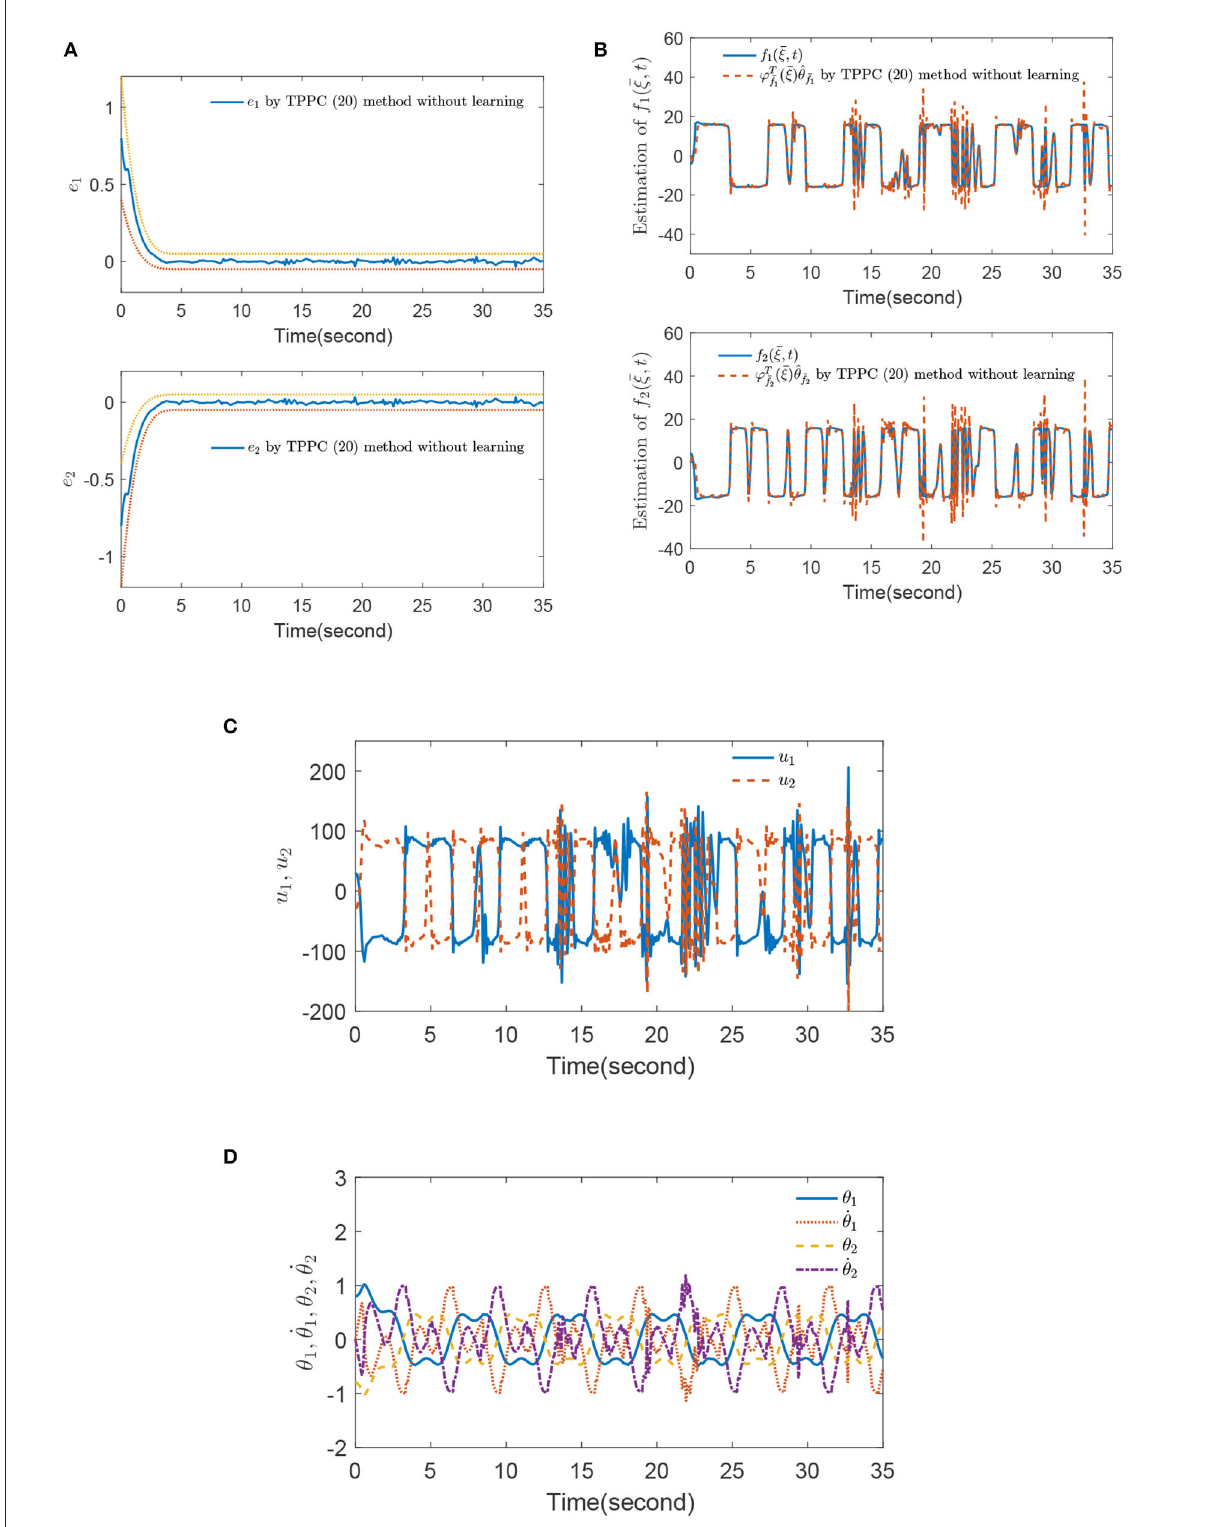
FIGURE2 (A) Tracking errors e 1 and e 2 , (B) estimation of f 1 ( ¯ ξξξ , t ) and f 2 ( ¯ ξξξ , t ), (C) control inputs u 1 and u 2 , and (D) states θ 1 , ˙ θ 1 , θ 2 , and ˙ θ 2 by using the time prescribed performance control (TPPC) method (Equation 20) without